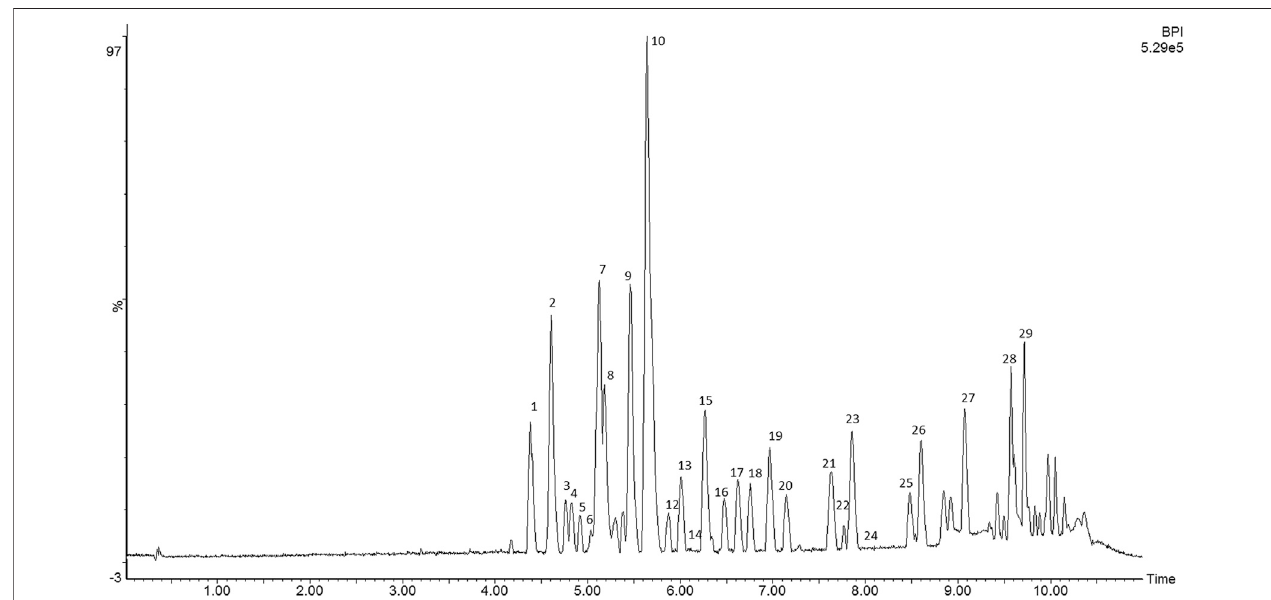
FIGURE 1 | Base peak ion chromatogram of propolis EtOH extract obtained by an MS E data collection technique method (UPLC-qTOF/MS E ) in negative mode.